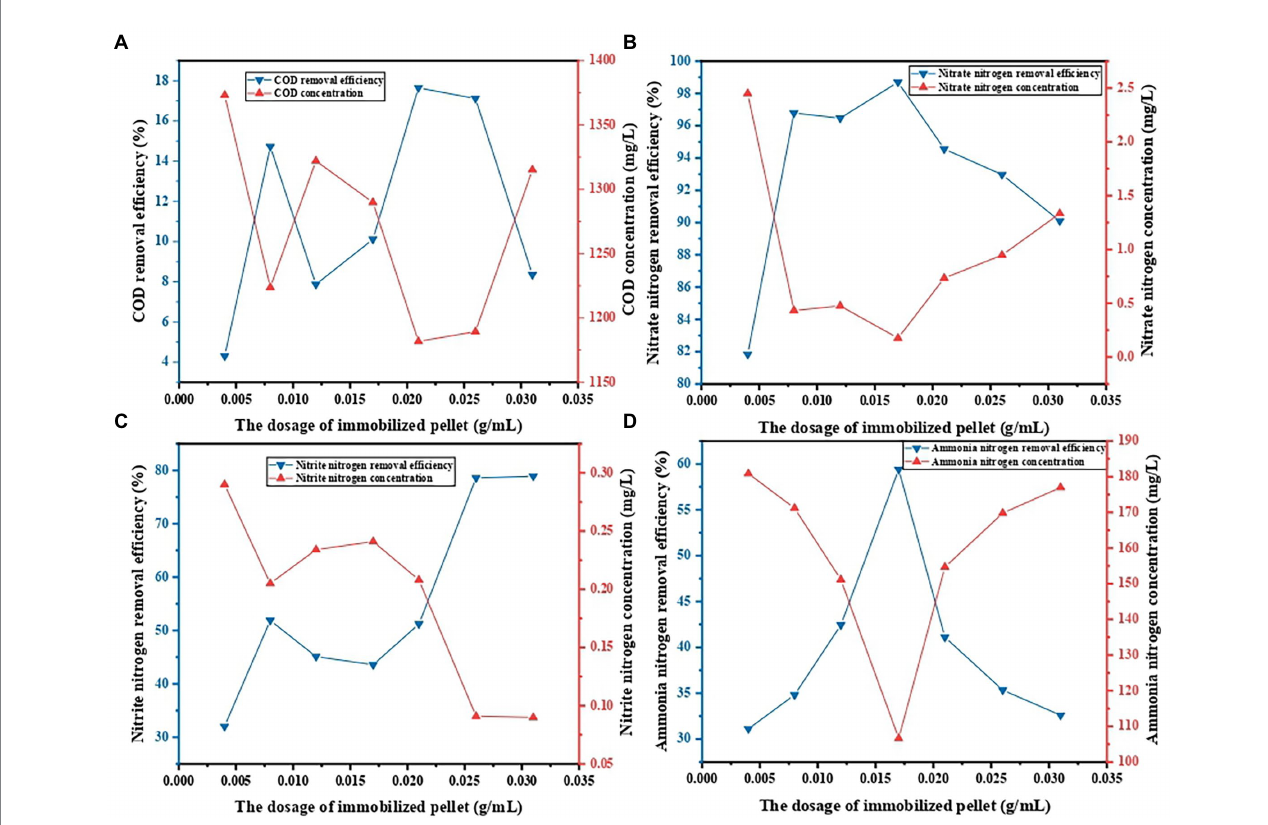
FIGURE 5 Effect of the dosage of immobilized pellet on contaminant removal: (A) COD removal, (B) NO 3 − -N removal, (C) NO 2 − -N removal, and (D) NH 4+ -N